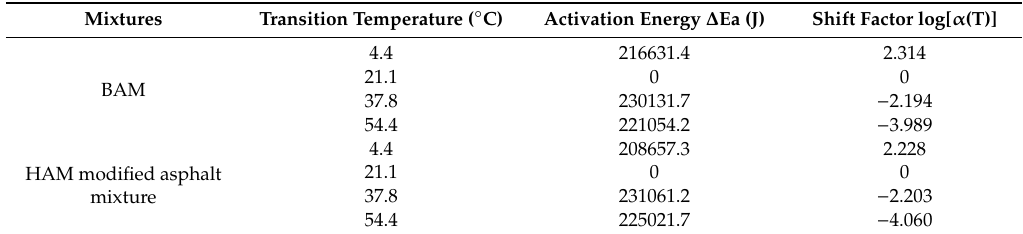
Table 6. Shift factors of mixtures.